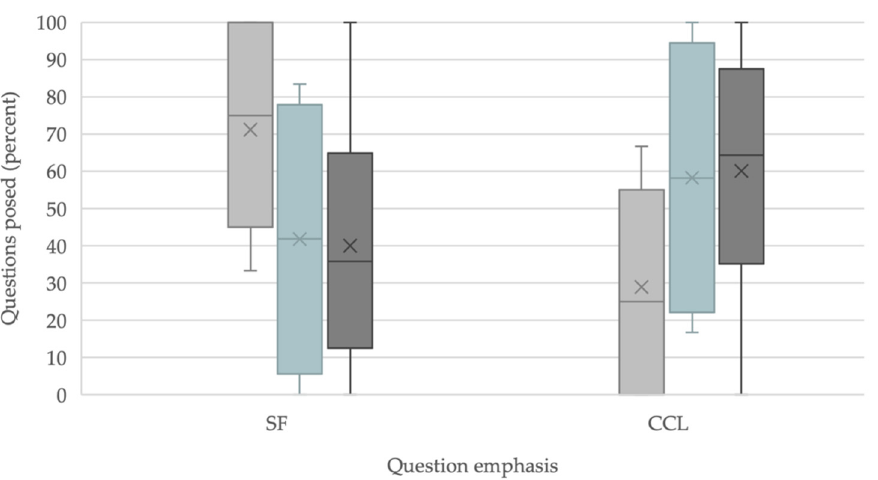
Figure 3. Percentage of questions that were considerations of SF or CCL from Design Sprint 1 (light gray bars), Project 5 (turquoise bar), and Design Sprint 2 (dark gray bars). The differences between percentages of CCL and SF questions asked were significant (Mann–Whitney U for CCL: p = 0.002, Z = − 3.10, U = 41, and for SF: p = 0.010, Z = − 2.56, U = 54.5).